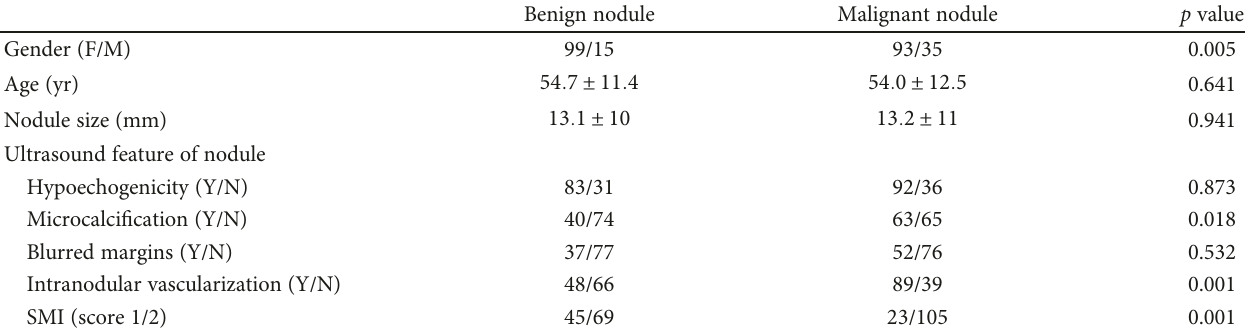
Table 3: Demographic and ultrasound characteristics between patients with benign and malignant nodule.